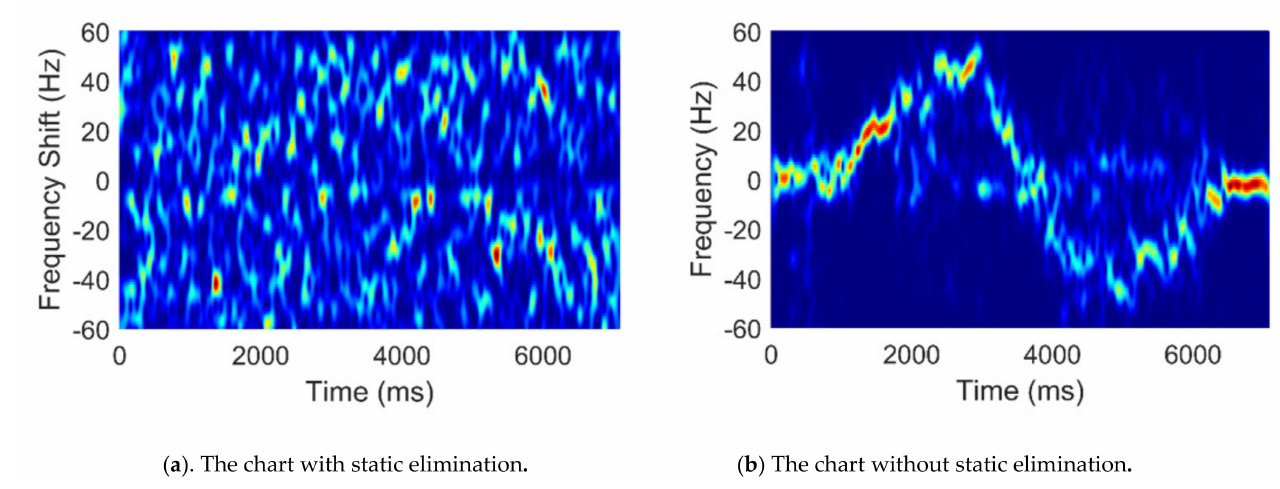
Figure 4. The measured time–frequency chart